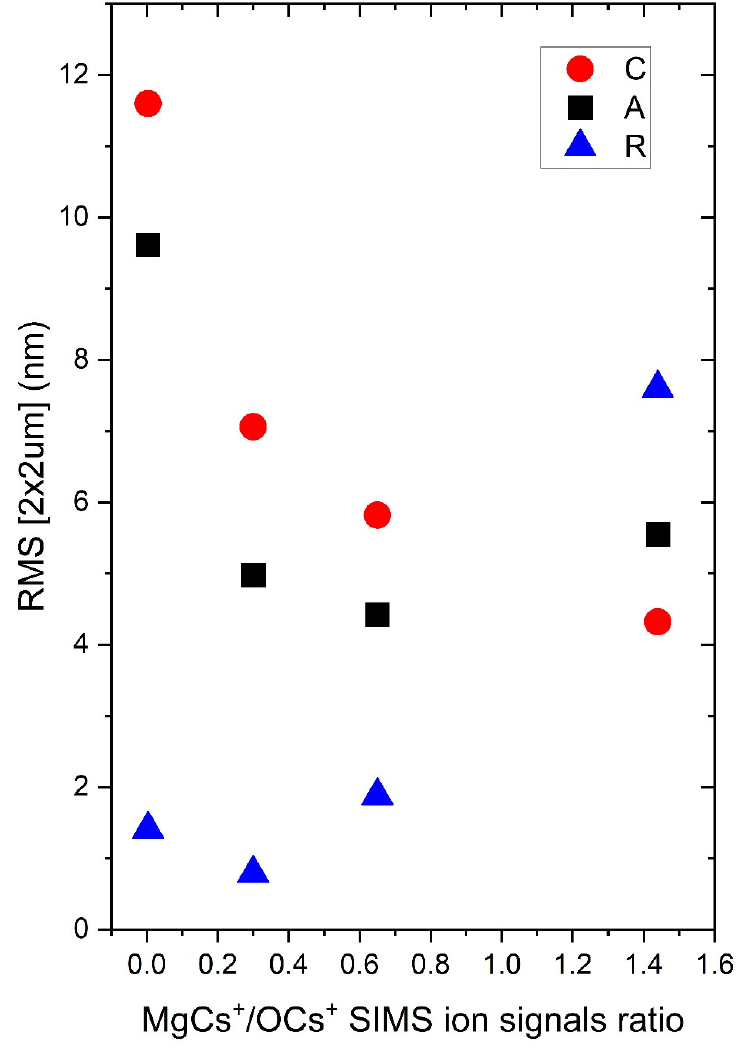
sapphires Figure 13. Root mean squares measured from 2 × 2 μ m area on samples grown on c ‐ , r ‐ , a ‐ oriented sapphires substrates.